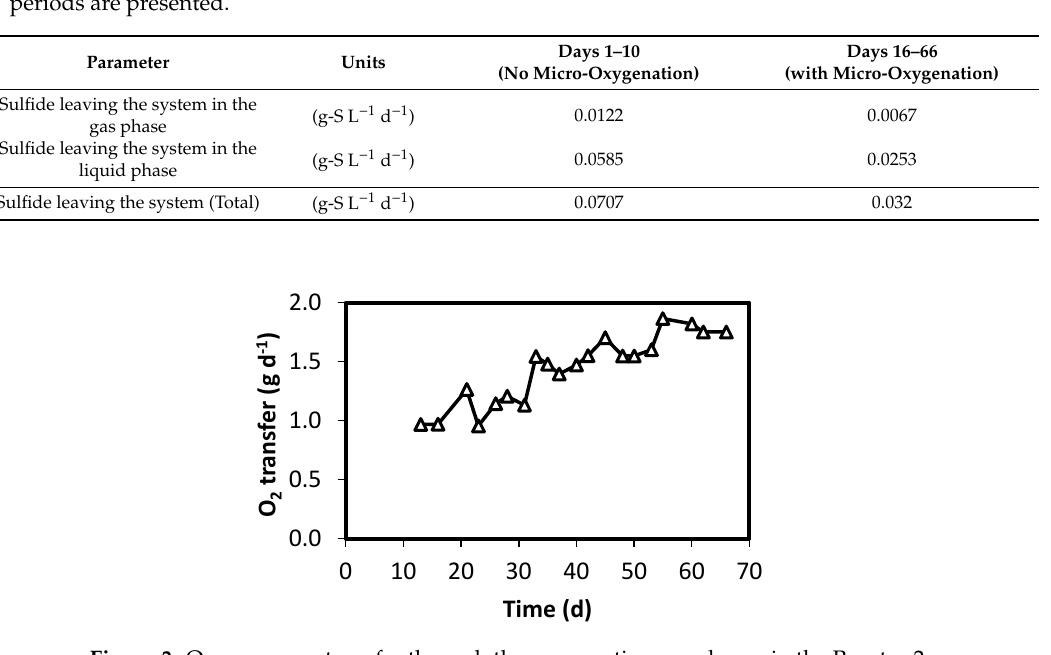
Figure 3. Oxygen mass transfer through the oxygenation membrane in the Reactor 2. Table 2. Sulfide loads leaving the system during Reactor 2 operation. Averages over the indicated periods are presented.